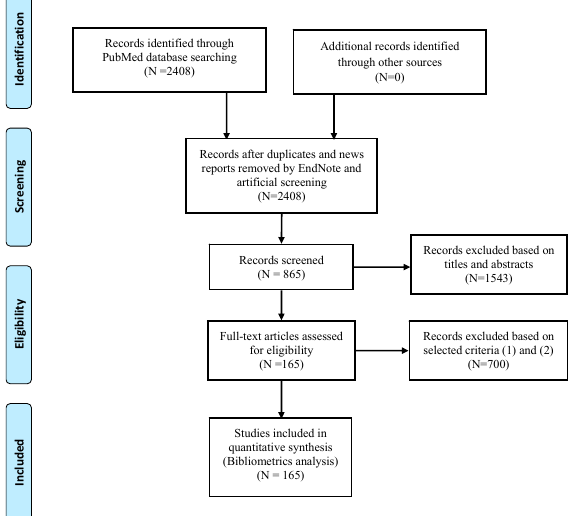
Figure 1. Flow diagram of study selection based on PRISMA 2009 guidelines [10] (PRISMA is an evidence-based minimum set of items for reporting in systematic reviews and meta-analyses).